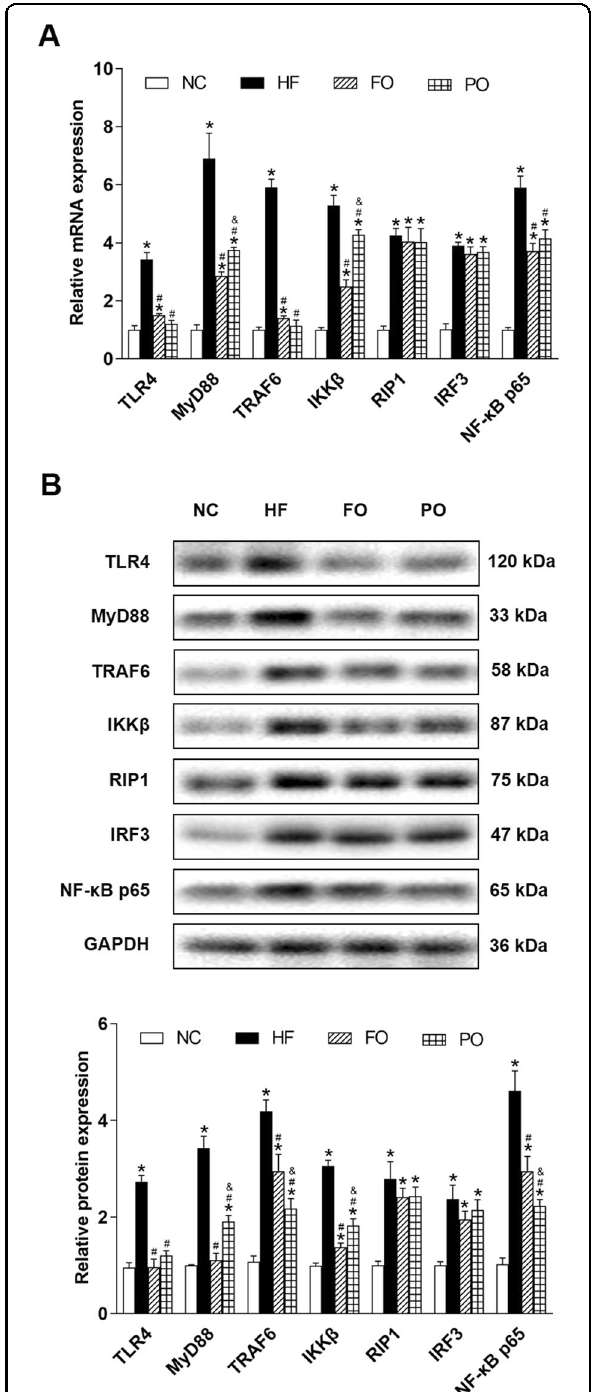
Fig. 2 Effects of FO and PO on MyD88-dependent and -independent pathways of TLR4 signaling in C57BL/6J mice. A Relative mRNA expression; B representative western blots images (upper) and relative protein expression (bottom). NC normal chow, HF high fat, FO fi sh oil, PO perilla oil, TLR4 toll-like receptor 4, MyD88 myeloid differentiation primary response 88, TRAF6 tumor necrosis factor receptor-associated factor 6, IKK β inhibitor of nuclear factor kappa B kinase beta, RIP1 receptor-interacting protein-1, IRF3 interferon regulate factor 3, NF- κ B p65 nuclear factor-kappa B p65, GAPDH glyceraldehyde-3-phosphate dehydrogenase. Data are presented as the mean ± standard deviation. * P < 0.05, compared with NC; # P < 0.05, compared with HF; & P < 0.05, compared with